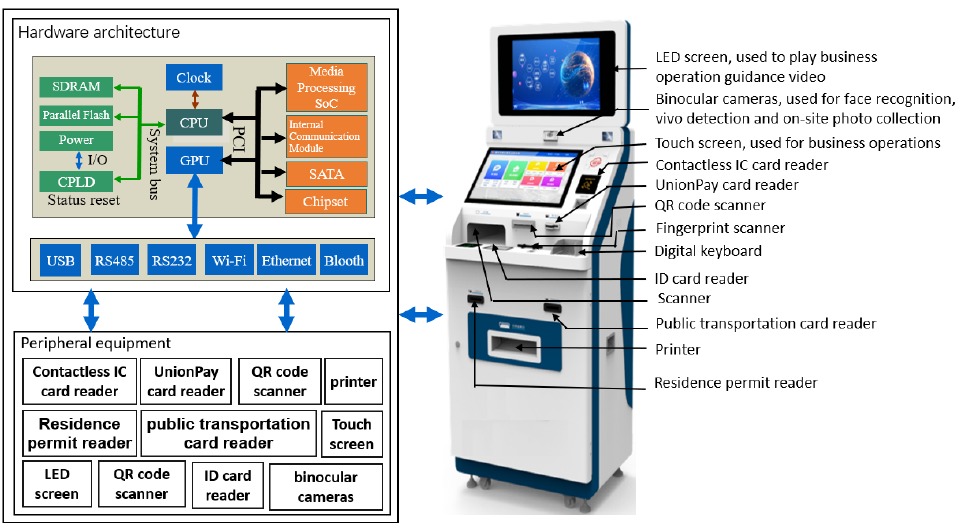
Figure 3. The hardware framework of self-service terminal.